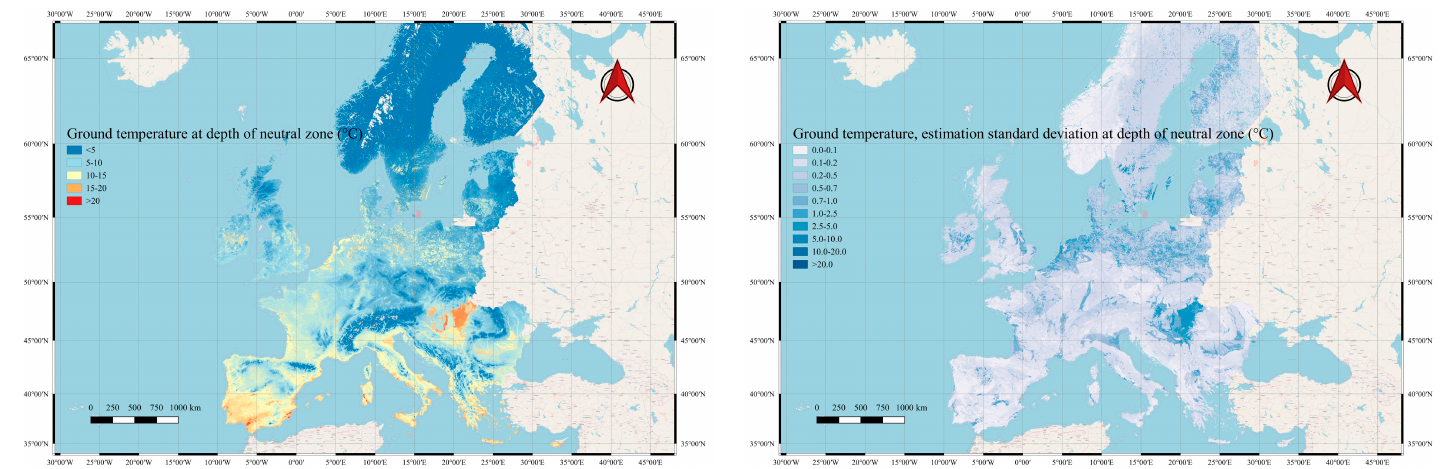
Figure 6. Estimation of average ( Left ) and standard deviation ( Right ) of ground temperature at neutral zone depth in Europe.